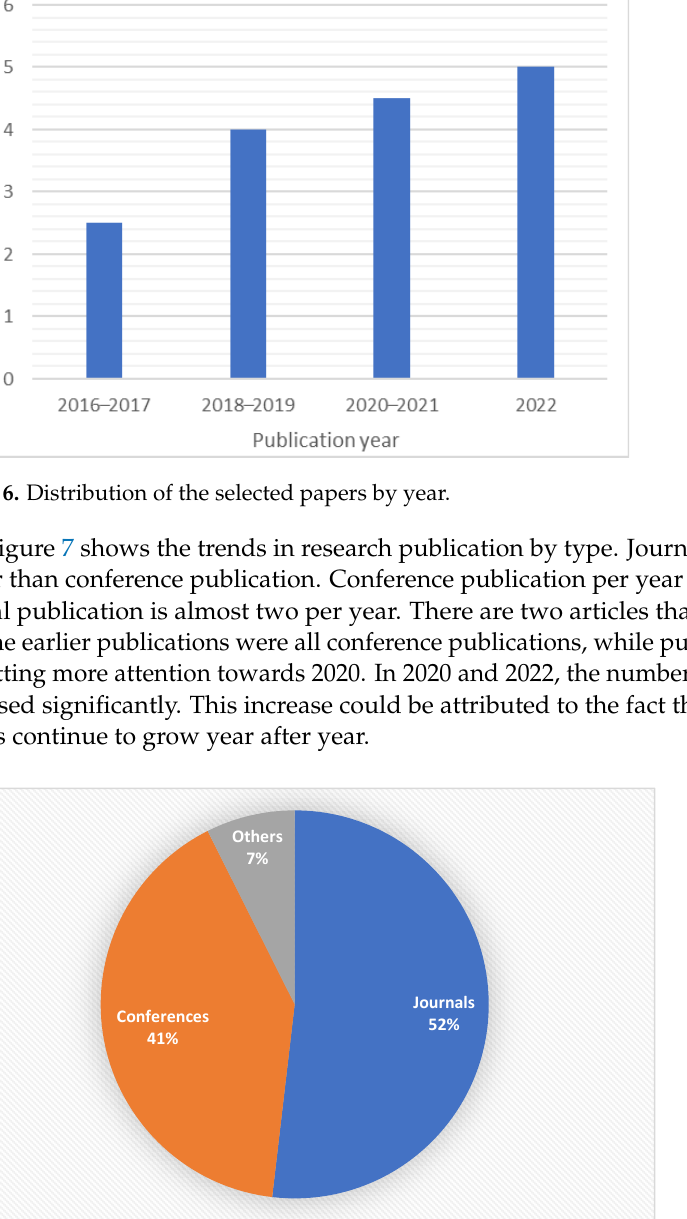
Figure 7. Distribution of the selected papers by type.